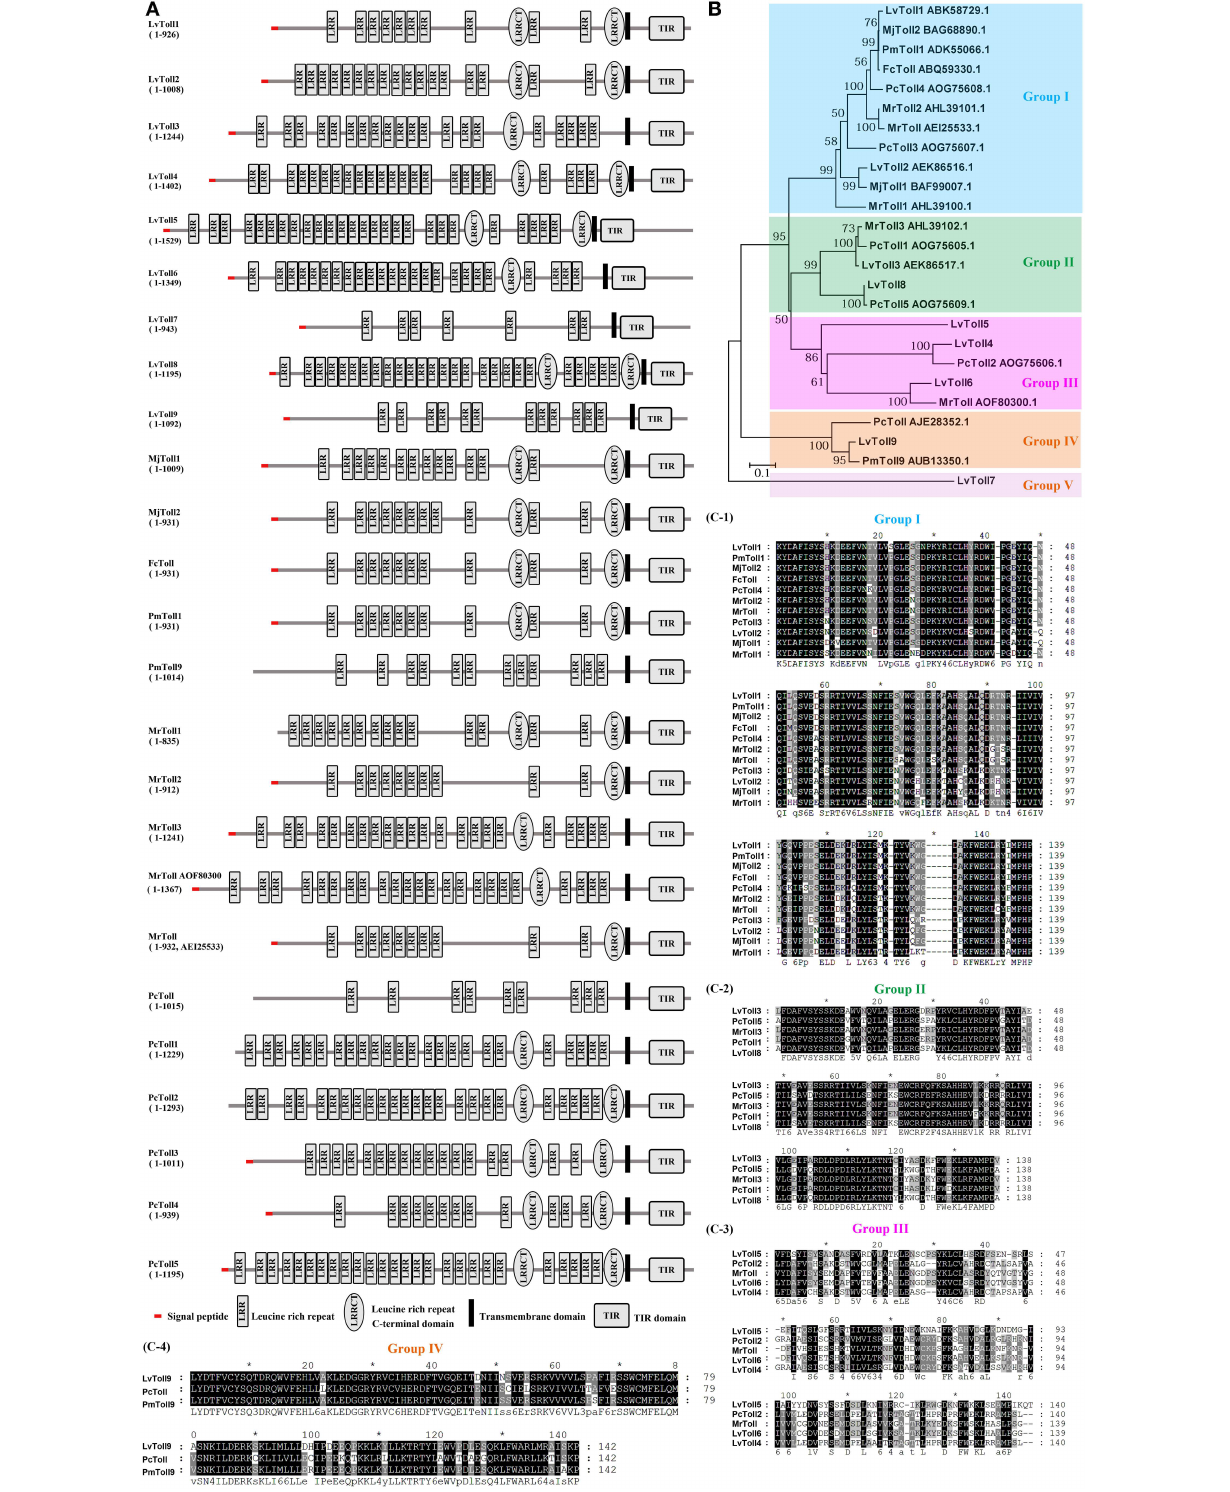
Frontiers in Immunology |